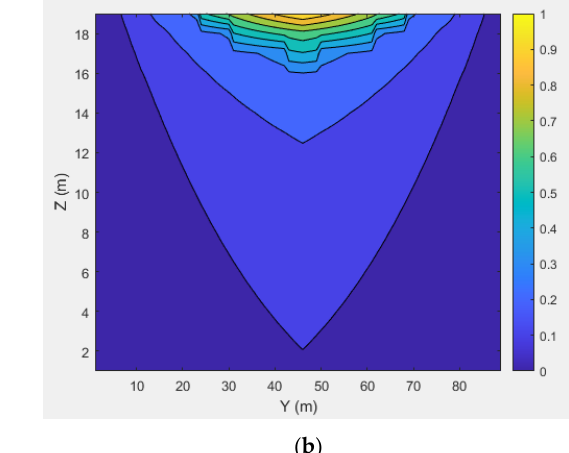
on the plane x = A